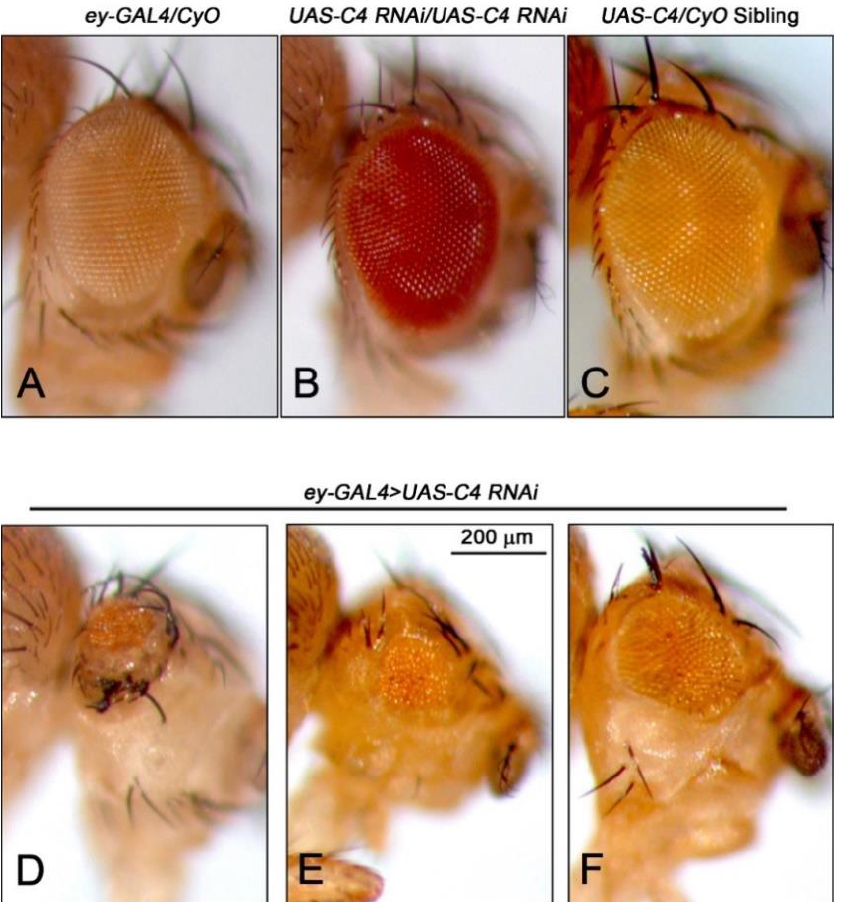
Figure 2. Eye phenotypes caused by nucleolar stress resulting from RNAi depletion of nucleolar phosphoprotein of 140 kDa (Nopp140) in the ey expression pattern ( ey-GAL4 > UAS-C4 ). Photographs representing eye size and morphology are presented by genotype: parental genotypes were ( A ) ey-GAL4/CyO and ( B ) flies homozygous for UAS-C4, the transgene encoding shRNA targeting the 5′ end of Nopp140 transcripts [29]; ( C ) UAS-C4/CyO sibling progeny did not express RNAi and, thus, served as controls; and ( D – F ) ey-GAL4/UAS-C4 siblings expressed RNAi. Eye phenotypes in ey-GAL4/UAS-C4 progeny were variable. Bar = 200 µm for all images. 2.2. Stress-Related Proteins Are Upregulated in Homozygous Nopp140 Gene Knockout Larvae Previous immunoblot results indicated that c-Jun N-terminal kinase (JNK) was ac- tivated and that the pro-apoptotic Hid protein was expressed in the larvae depleted for Nopp140 by RNAi expression [30]. We subsequently deleted the Nopp140 gene by recom- bination between flanking RB+ and WH- pBac elements. One of the Nopp140 deletion lines is referred to as KO121 [31]. We used Western blots and an antibody directed against activated JNK (pJNK) (Cell Signaling) to show that JNK is activated in larvae homozygous for the KO121 Nopp140 gene deletion (Figure 3A). Wild type larvae ( w 1118 ) and larvae homozygous for the downstream pBac element ( WH-/- ) used to delete Nopp140 served as controls. We often detected two JNK bands at about 43 kDa as shown in Figure 3A but would just as often see a single JNK band (Figure S2) [37–39]. As far as we know, Drosophila has just one isoform of JNK, so we attribute the two bands in Figure 3A to partial proteolysis. In addition to JNK activation, the pro-apoptotic Hid protein was upregulated in the KO121 Nopp140-/- larvae (Figure 3A). We also observed Hid induction in larvae depleted for Nopp140 by RNAi expression (Figure S2), confirming the onset of apoptosis either by RNAi depletion of Nopp140 or by KO121 Nopp140 gene